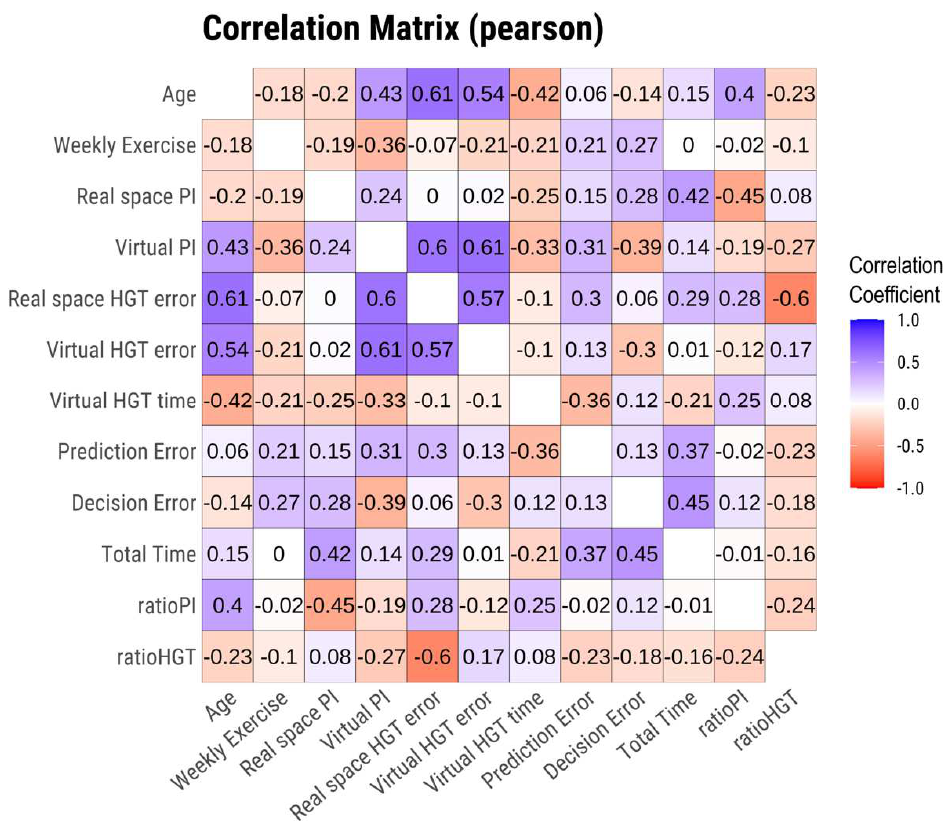
Figure 4. Correlation matrix of key measurements of the different tests. Both positive and negative potential correlations can be seen. Note the higher correlation coefficient between age and performance of some of the tests, and the coefficient between the real-space and virtual versions of the tests. This matrix was used to analyze specific correlations in more detail (Figure 5).